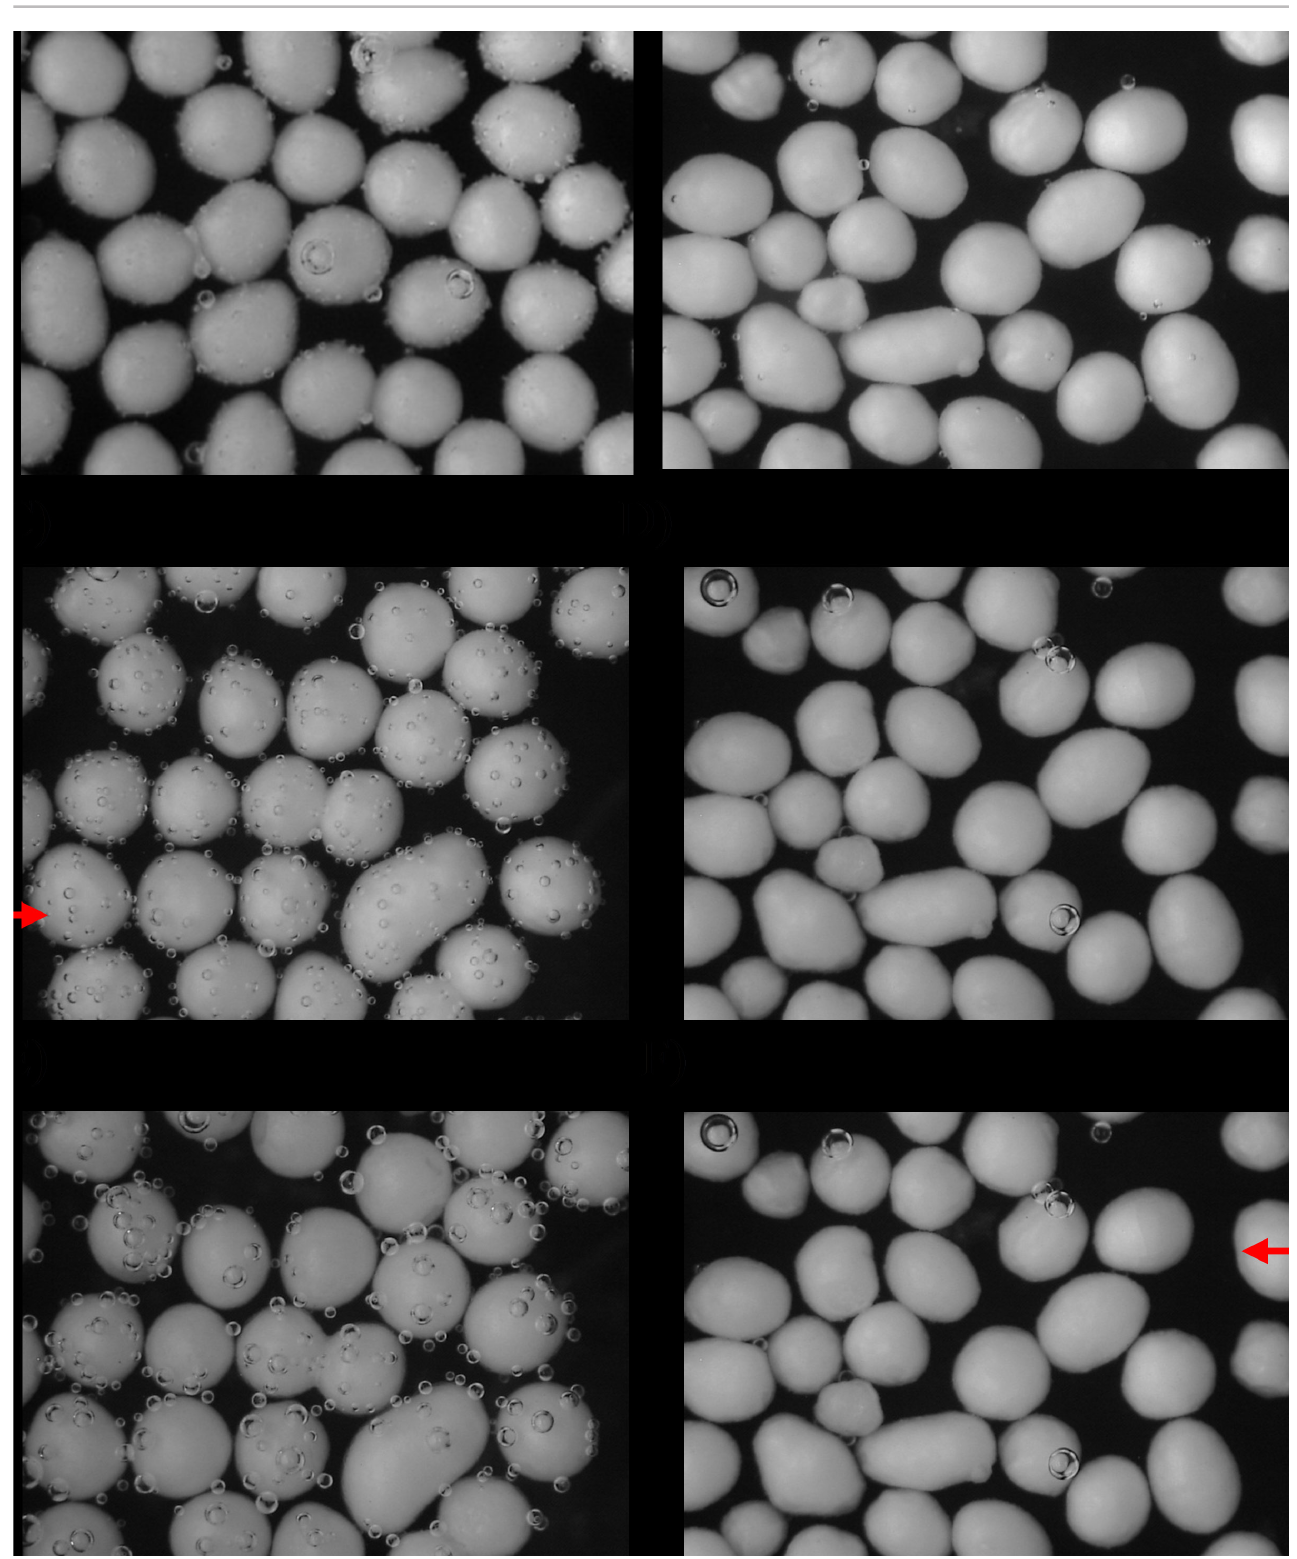
FIGURE 4 - Macroscopic pictures of uncured and cured (60 °C/75% RH/24 h) pellets based on sugar cores loaded with 10% propranolol HCl coated with Aquacoat ® ECD using talc 35% as a function of time in 0.01 N